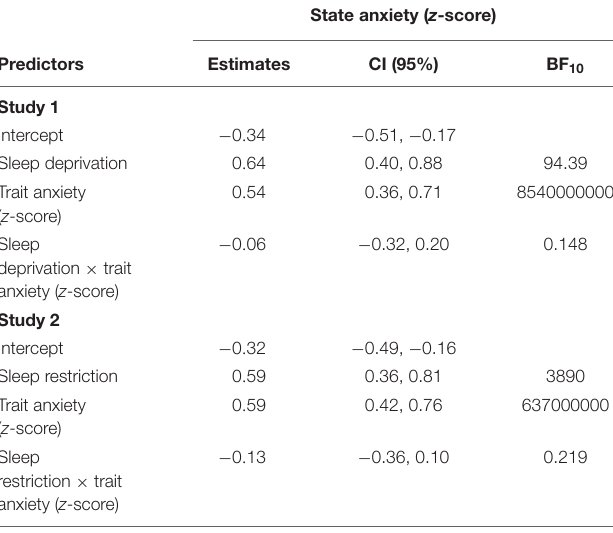
TABLE 2 | Full models predicting state anxiety for studies 1 and 2.